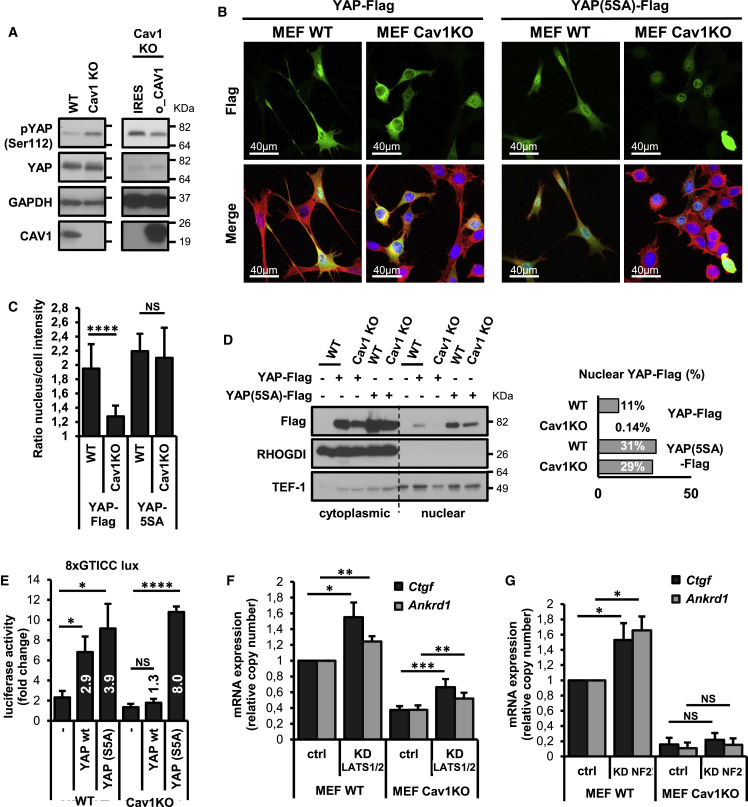
Hippo-Kinase-Independent YAP Serine Phosphorylation Determines Impaired Nuclear Translocation and Blunted YAP-Dependent Transcriptional Activity in Cav1KO Cells(A) Western blot of Ser112-phopshorylated YAP and total YAP in WT and Cav1KO MEFs and Cav1KO MEFs reconstituted with CAV1 (o_CAV1) or IRES-GFP.(B) Confocal immunofluorescence of cells transfected with YAP-FLAG or YAP(S5A)-FLAG and stained with anti-FLAG antibody (green), fluorophore-conjugated phalloidin (red), and Hoechst (blue).(C) FLAG distribution from analysis as in (B), represented as the ratio of nuclear-to-cytosolic intensities. n = 6–11.(D) Western blot analysis of FLAG subcellular distribution in MEFs transfected with YAP-FLAG or YAP(S5A)-FLAG followed by biochemical fractionation. RHO-GDI and Tef-1 were used as cytosolic and nuclear markers, respectively. The percentage of total YAP located in the nuclear fractions was quantified (right graph).(E) TEAD transcriptional activity in MEFs transfected with YAP-FLAG and YAP(S5A)-FLAG, measured by 8xGTICC-luciferase reporter assay. Data are normalized to growth on the soft substrate in each experiment. n = 3 (E). The fold-change with respect to untransfected cells is indicated above the bars.(F) qRT-PCR for Ctgf and Ankrd1 expression in WT and CAV1 KO MEFs transfected with control or Lats1 and 2 siRNAs. Data are normalized to WT control. n = 10.(G) qRT-PCR for Ctgf and Ankrd1 expression in WT and CAV1 KO MEFs transfected with control or NF2 siRNAs. Data are normalized to WT control. n = 4.Data are presented as mean ± SEM; ∗p < 0.05, ∗∗p < 0.01, ∗∗∗p < 0.005, and ∗∗∗∗p < 0.0005. See also Figure S2.